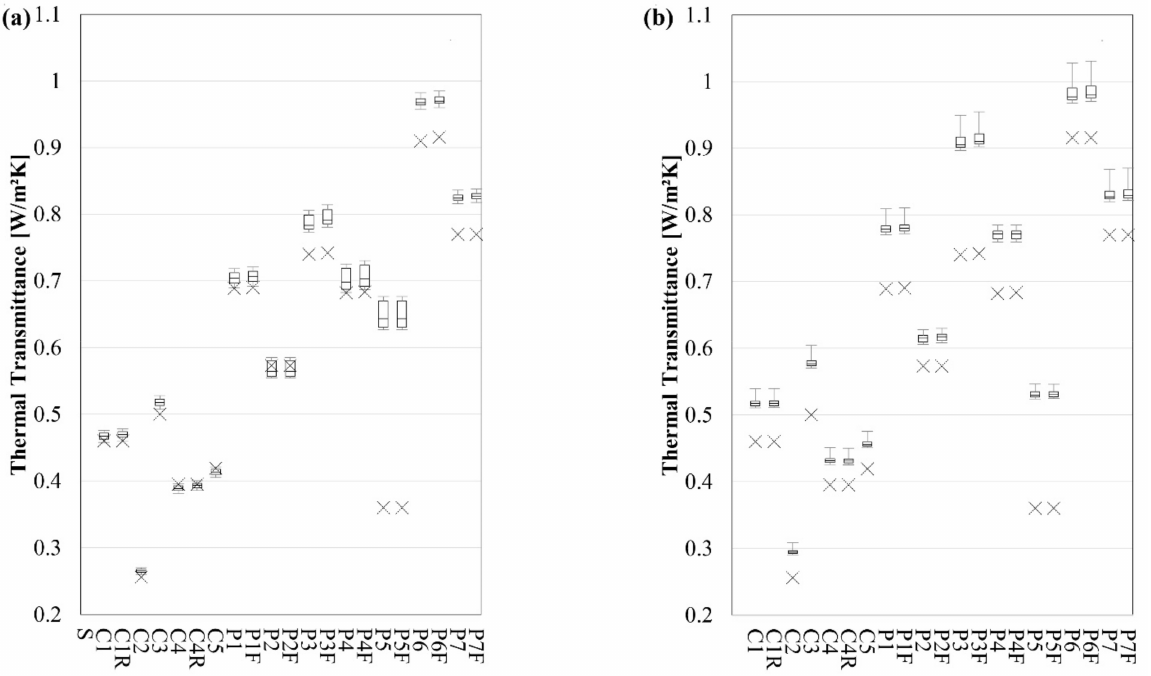
Figure 7. Box plots: Thermal transmittance values of the wall, U [W/m 2 K], in the winter period (October–April) in Monfero ( a ) and Turin ( b